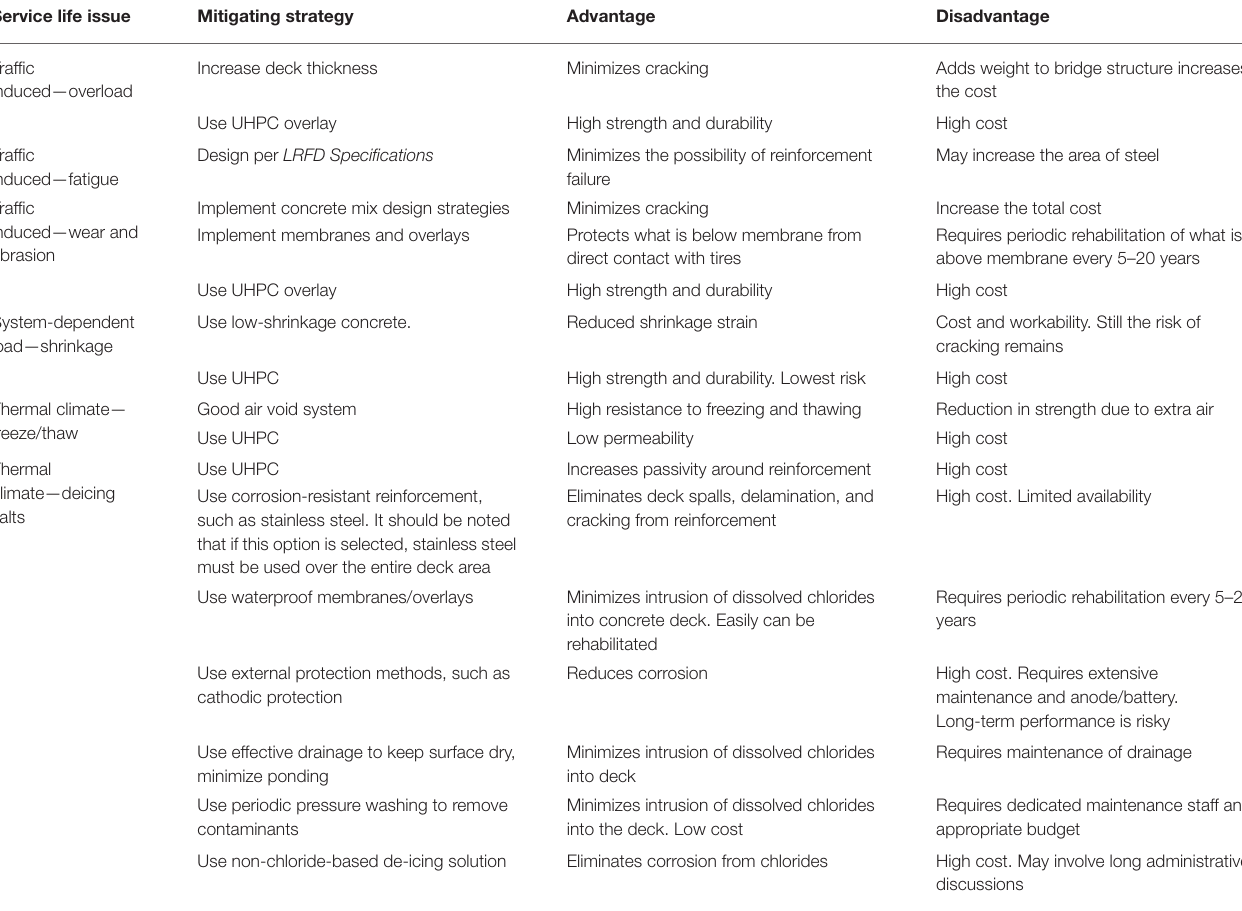
TABLE 1 | List of individual strategies for mitigating load induced and thermal climate